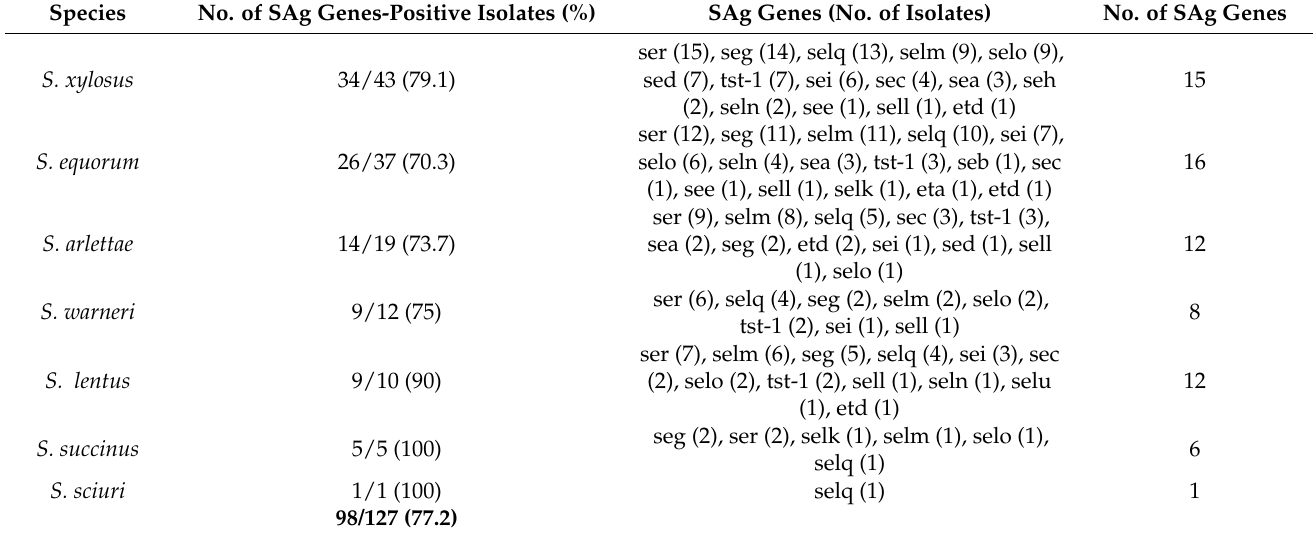
Table 3. Distribution of superantigen (SAg) genes profile among Staphylococcus species.